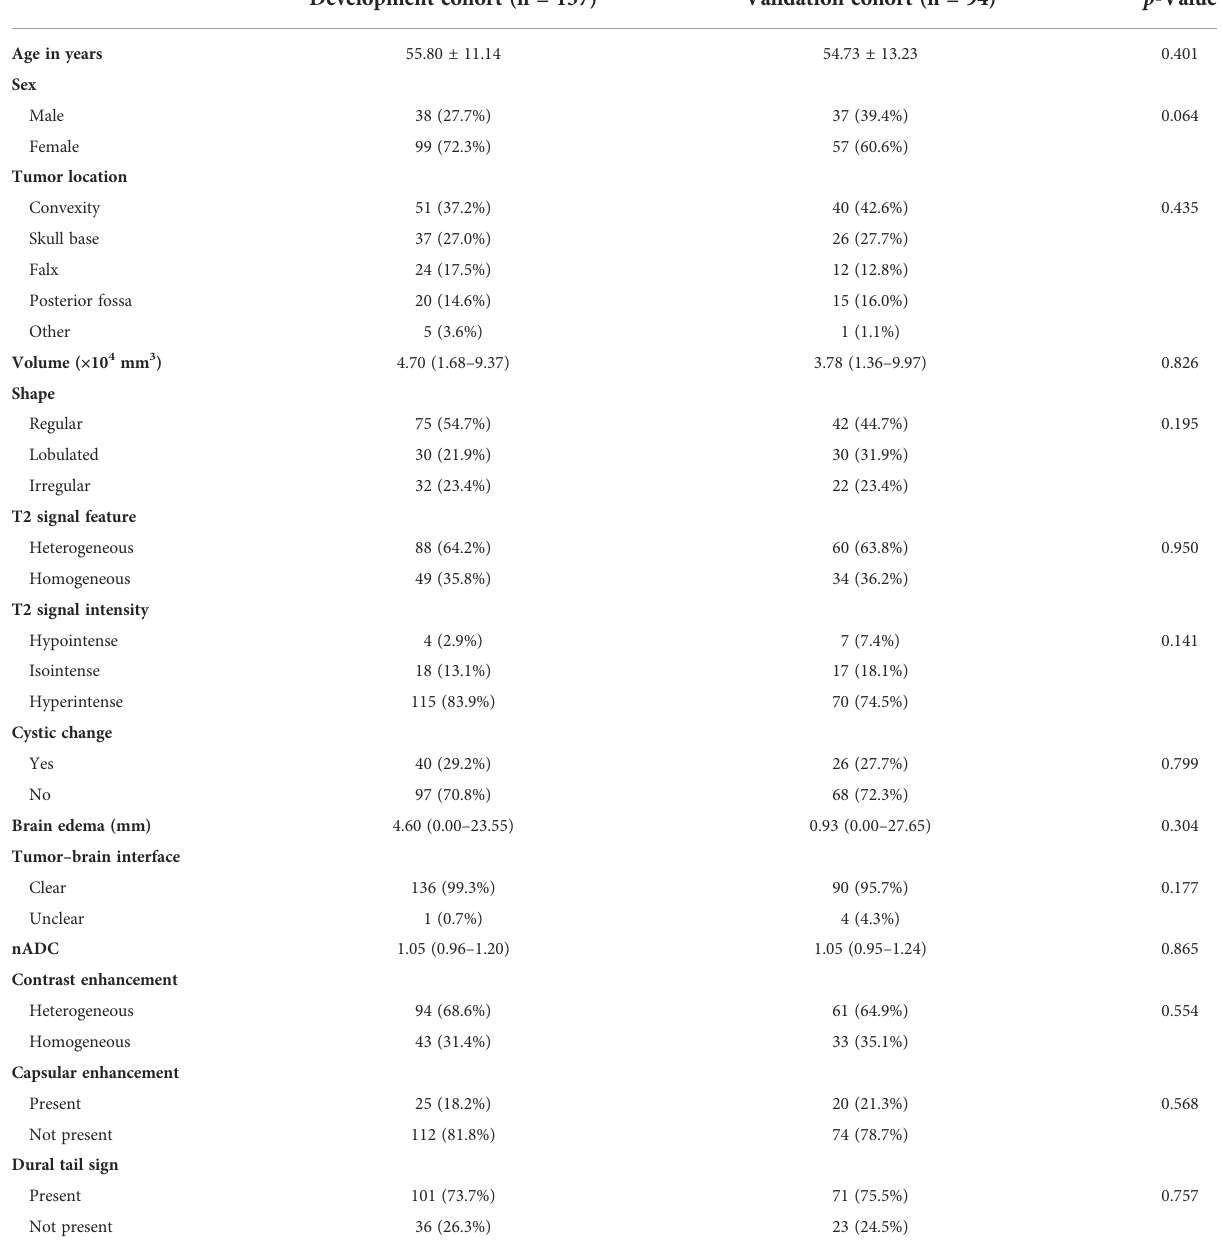
TABLE 2 Characteristics of patients in the development and validation